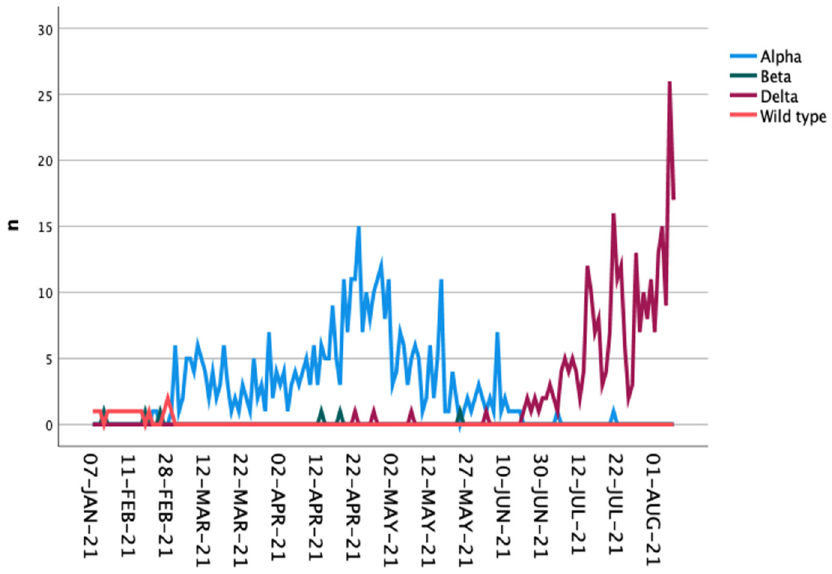
Figure 2. Occurrence of the different virus variants during the observation period in Cologne.